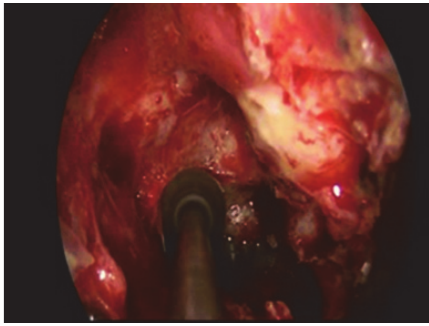
Figure7:Endoscopicimage:posteriorethmoidalartery:hemostasis with diamond drill.